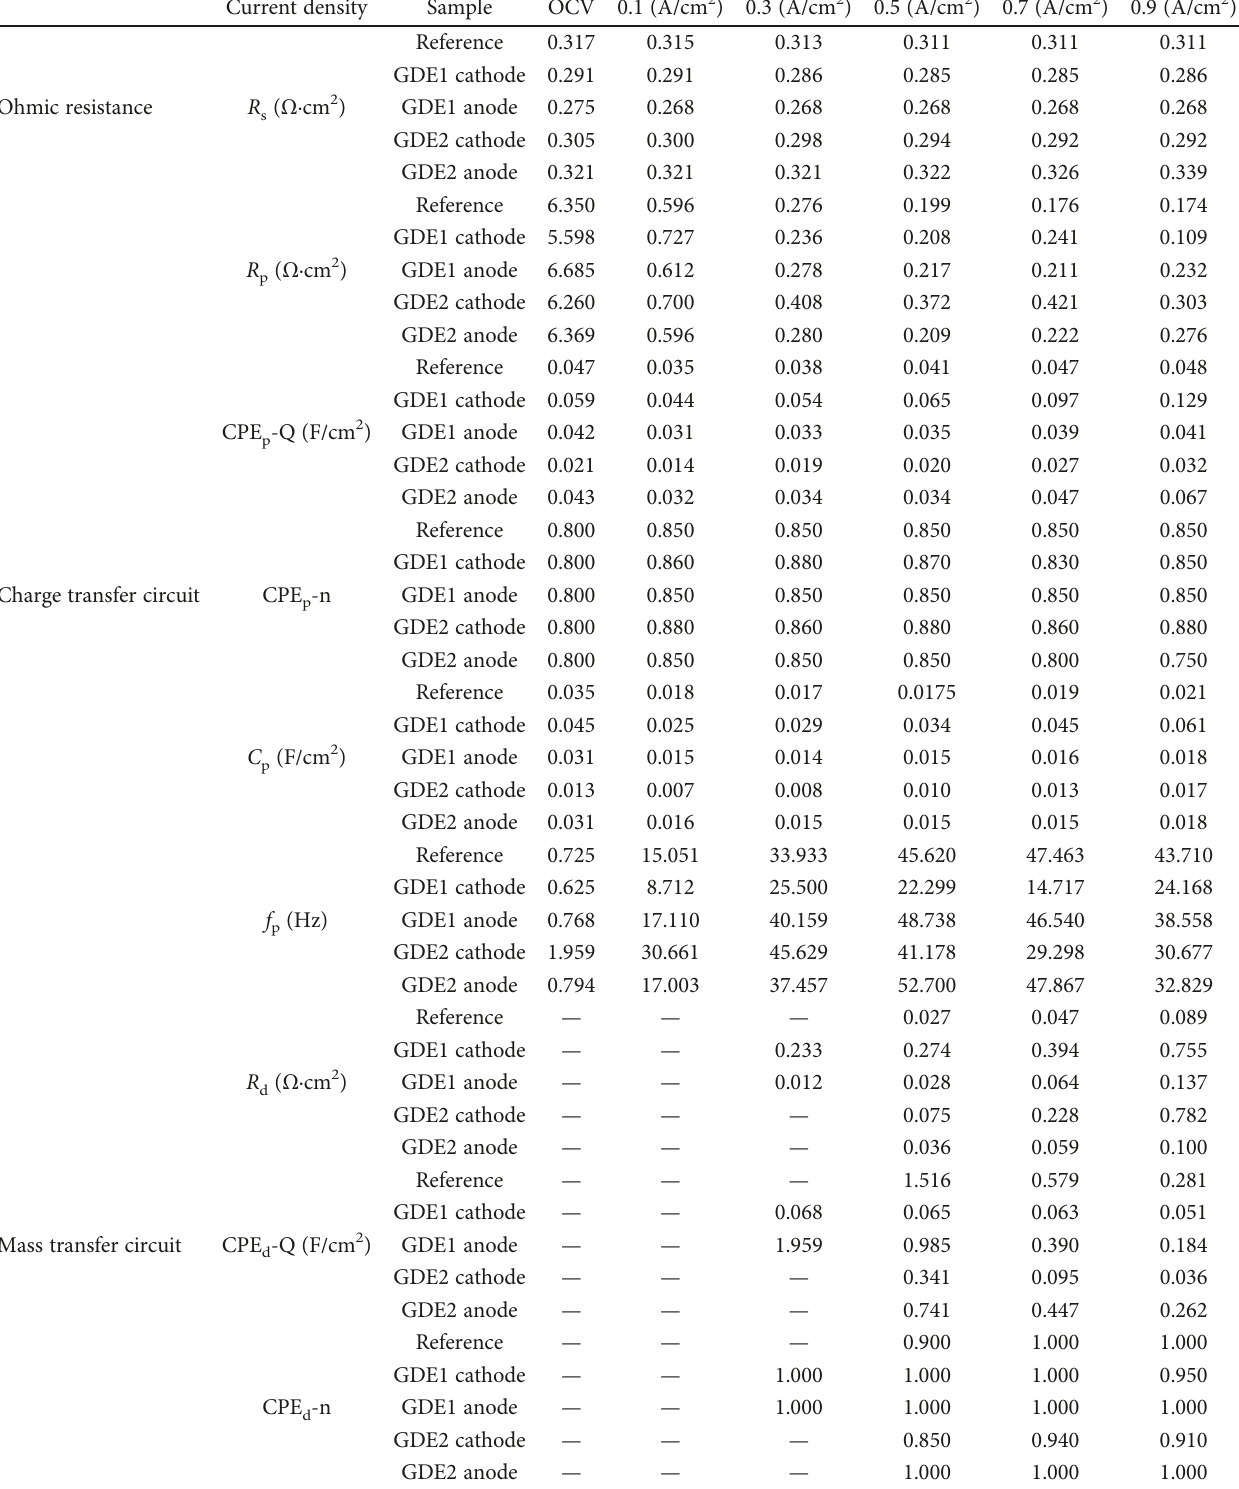
Table 1: The fi tting parameters for the impedance spectra at di ff erent current densities (i.e., from OCV to 0.9A/cm 2 ) and high inlet gas fl ow rate (H /air: 2